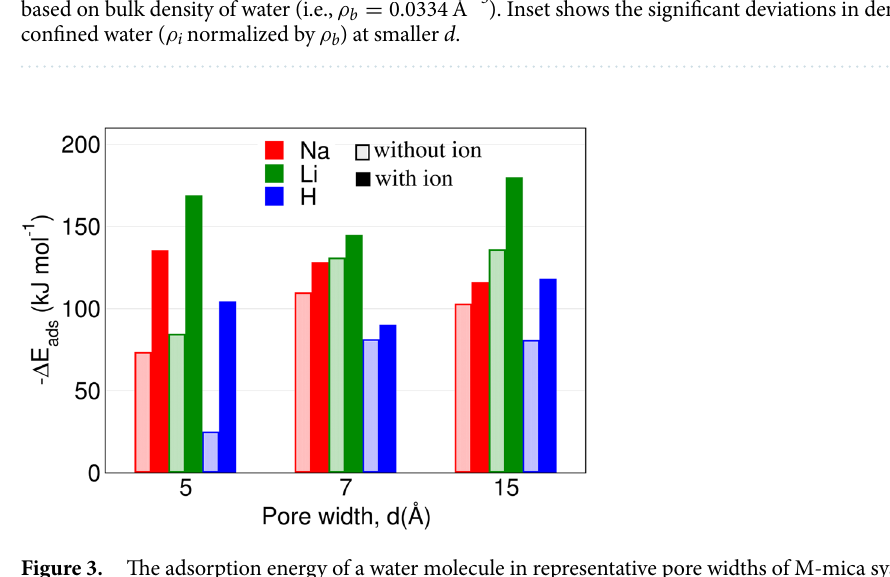
Figure 3. The adsorption energy of a water molecule in representative pore widths of M-mica